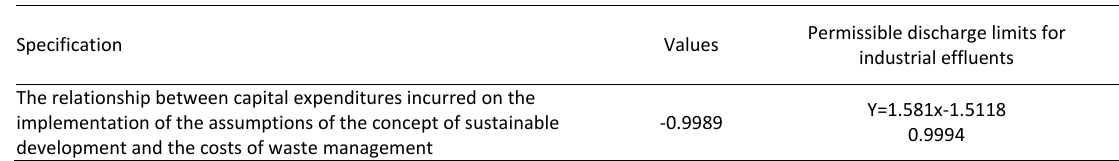
Table 1: The relationship between capital expenditures incurred on the implementation of the assumptions of the concept of sustainable development and the costs of waste